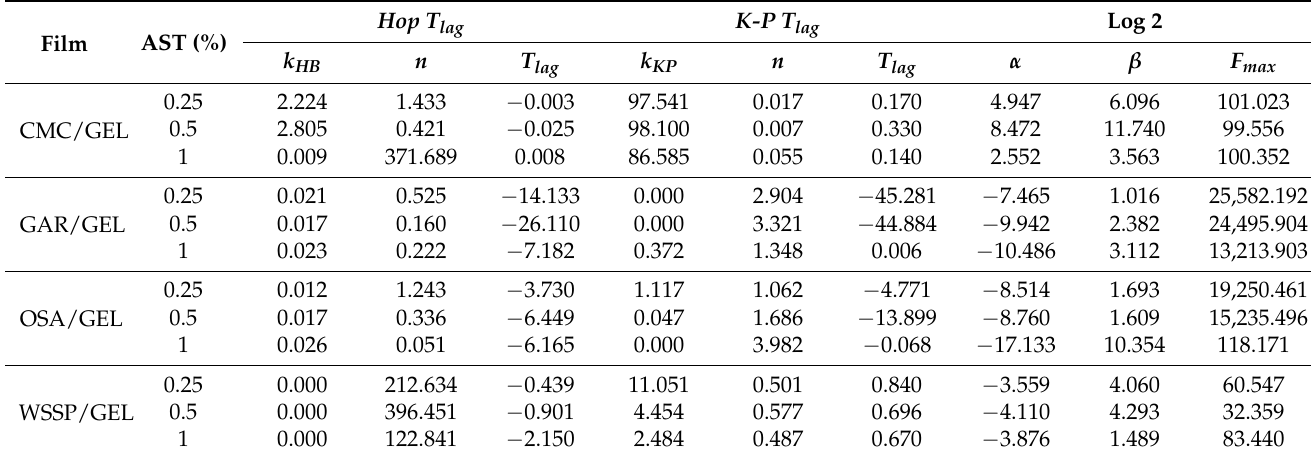
Table 5. Kinetic parameters obtained from three-parameter modeling.